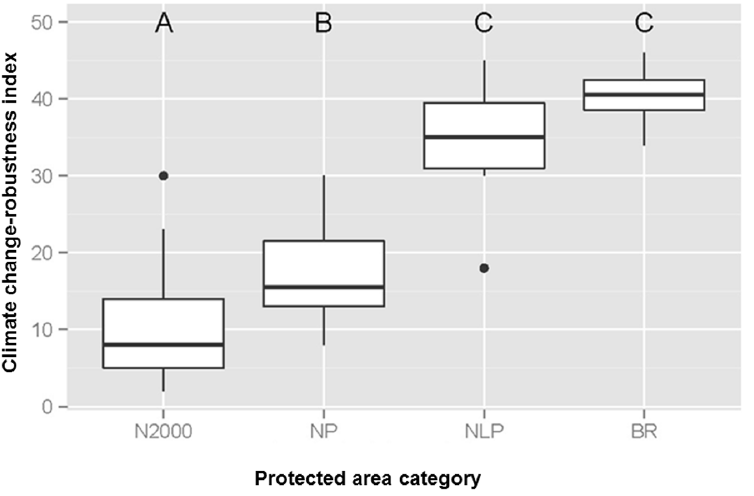
Fig 3. Relationship between the four protected area categories and climate change-robustness. BR = biosphere reserves, NLP = nationalparks, NP = nature parks, N2000 = Natura 2000 sites; different capitalletters indicatesignificantly different groups.